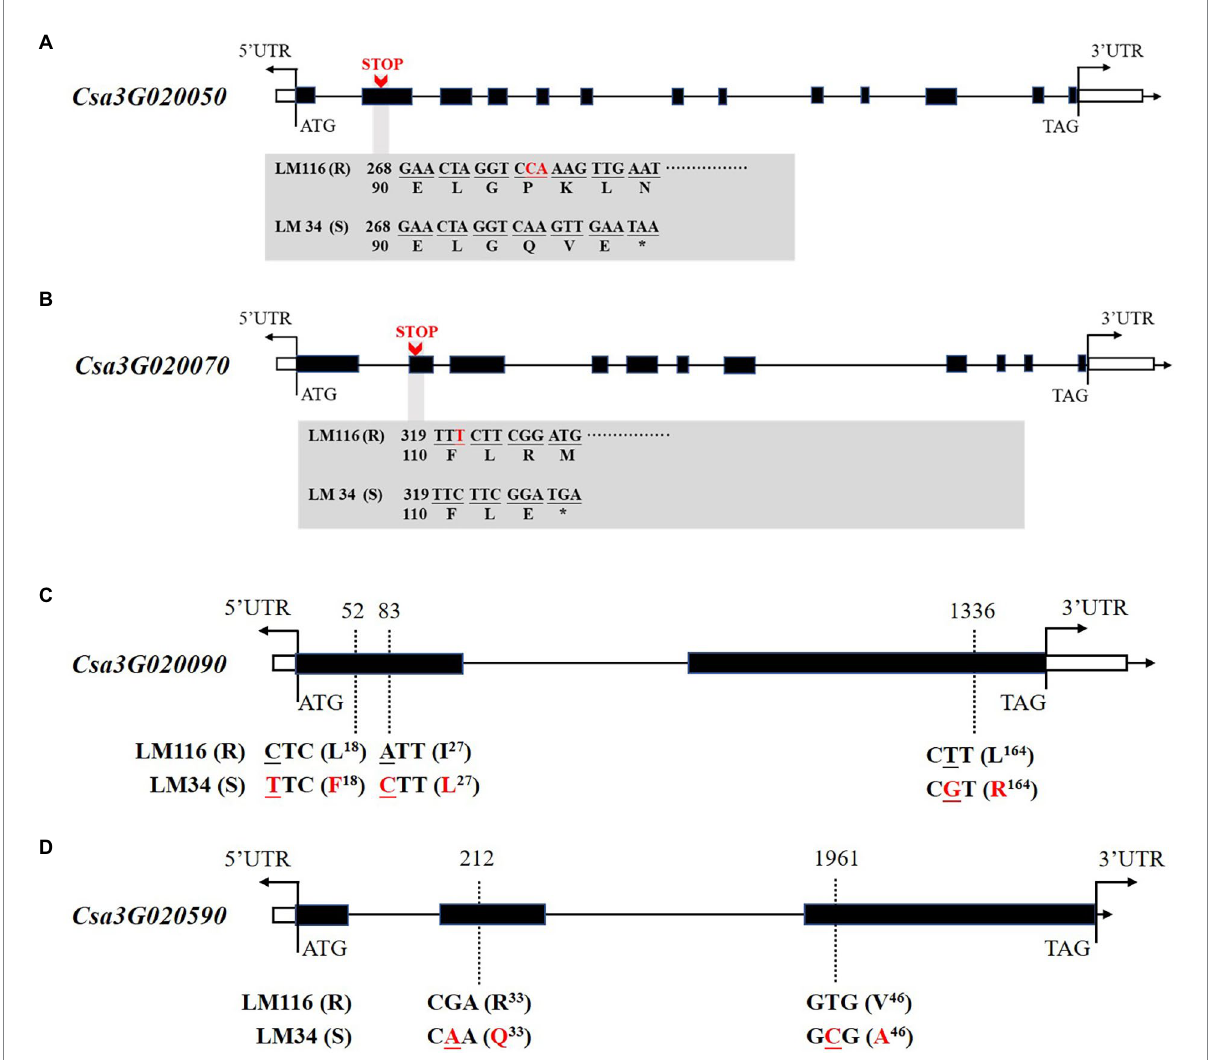
FIGURE 5 Gene structures and nonsynonymous variations of Csa3G020050 (A) , Csa3G020070 (B) , Csa3G020090 (C) , and Csa3G020590 (D) between LM116 and LM34. Nonsynonymous variations are labeled in red font. “STOP” indicates premature translation termination